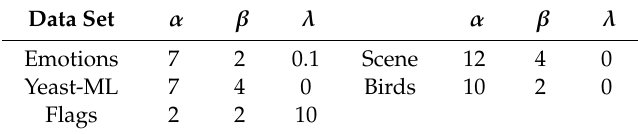
Table 11. Pre-defined constants for RBF-ISCC for multi-label data